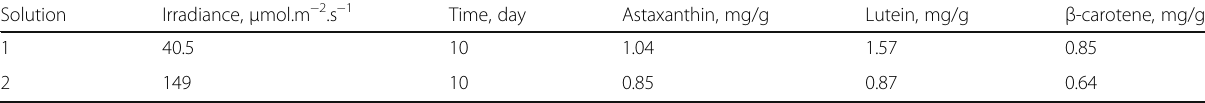
Table 3 The optimum conditions for carotenoids